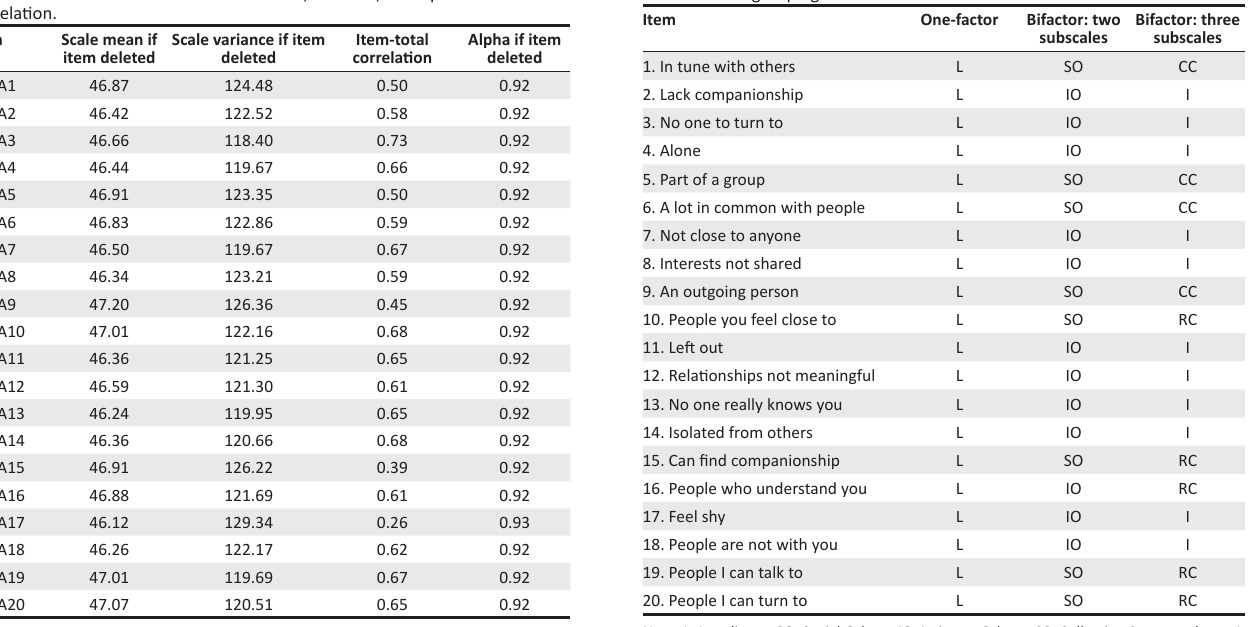
TABLE 1: The influence of items on the mean, variance, and alpha and item-total correlation. Item Scale mean if Scale variance if item Item-total item deleted deleted correlation